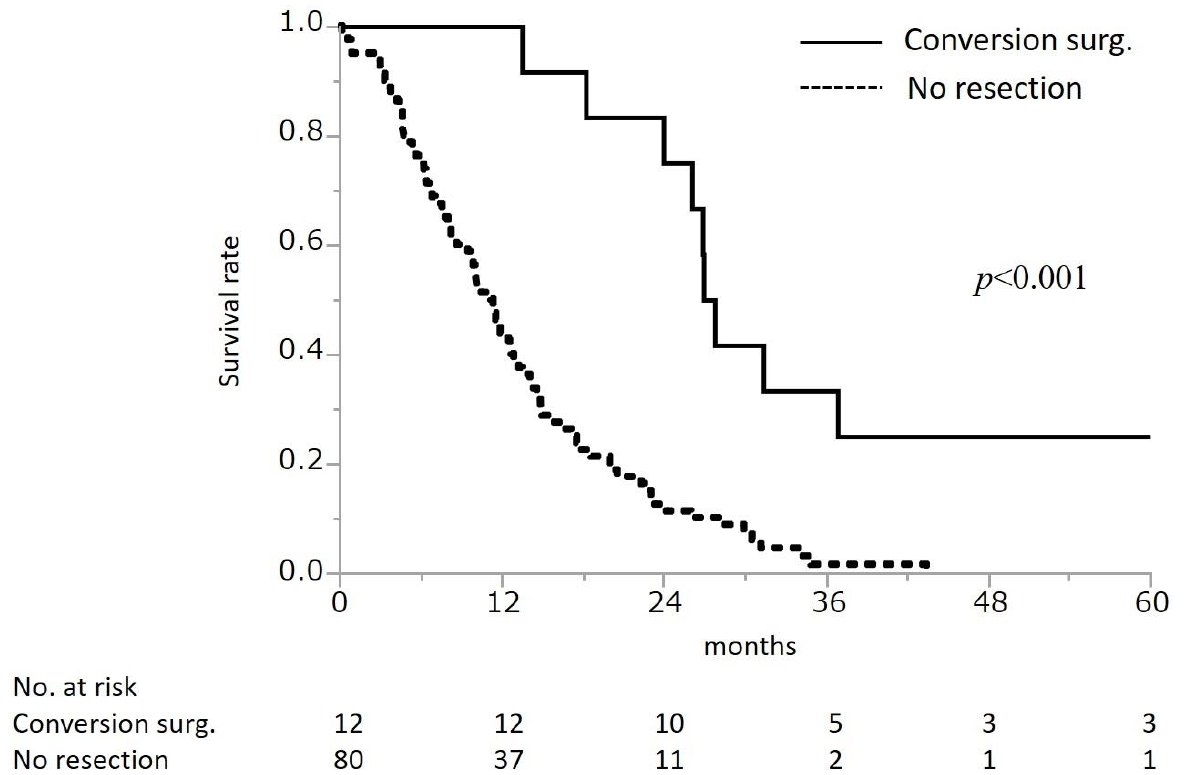
Figure 3. Overall survival from initial treatment by surgery status The p -value was calculated by log-rank test. The median survival time was 27.4 months in patients who underwent conversion surgery ( n = 12), and 11.3 months in patients who did not undergo resection ( n = 80).